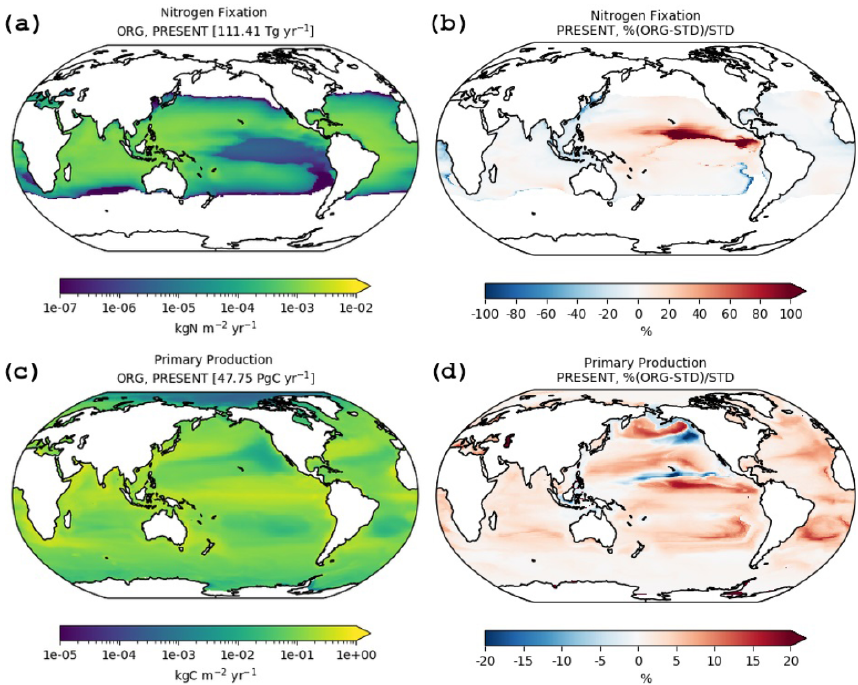
Figure 8. Nitrogen-fixation (kgNm − 2 yr − 1 ) and primary production (kgCm − 2 yr − 1 ) rates as calculated by the model (a, c) for the ORG simulation for PRESENT, and the respective relative (%) differences (b, d) compared to the STD